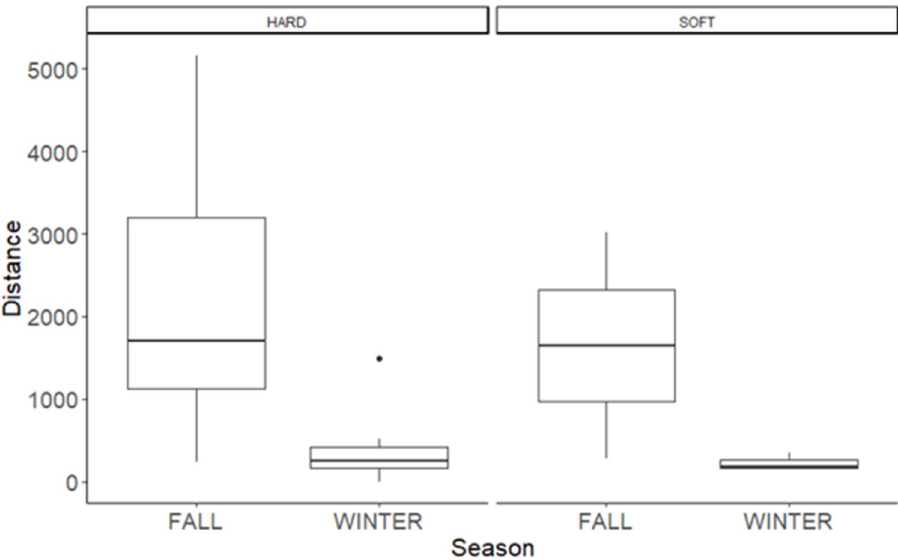
Fig 4. Plot of mean, sd, minimum and maximum distance of settlement site to release site (fall: mean 1752, sd 1472, maximum 5162, minimum 233). Winter: mean 364, sd 421, maximum 1494, minimum 0 (one squirrel stayed at the release site), and number of days passed before squirrel ( Tamiasciurus fremonti fremonti ) settled (Fall: mean 23, sd 13.6, maximum 57, minimum 8. Winter: mean 6, sd 2.45, maximum 11, minimum 3).